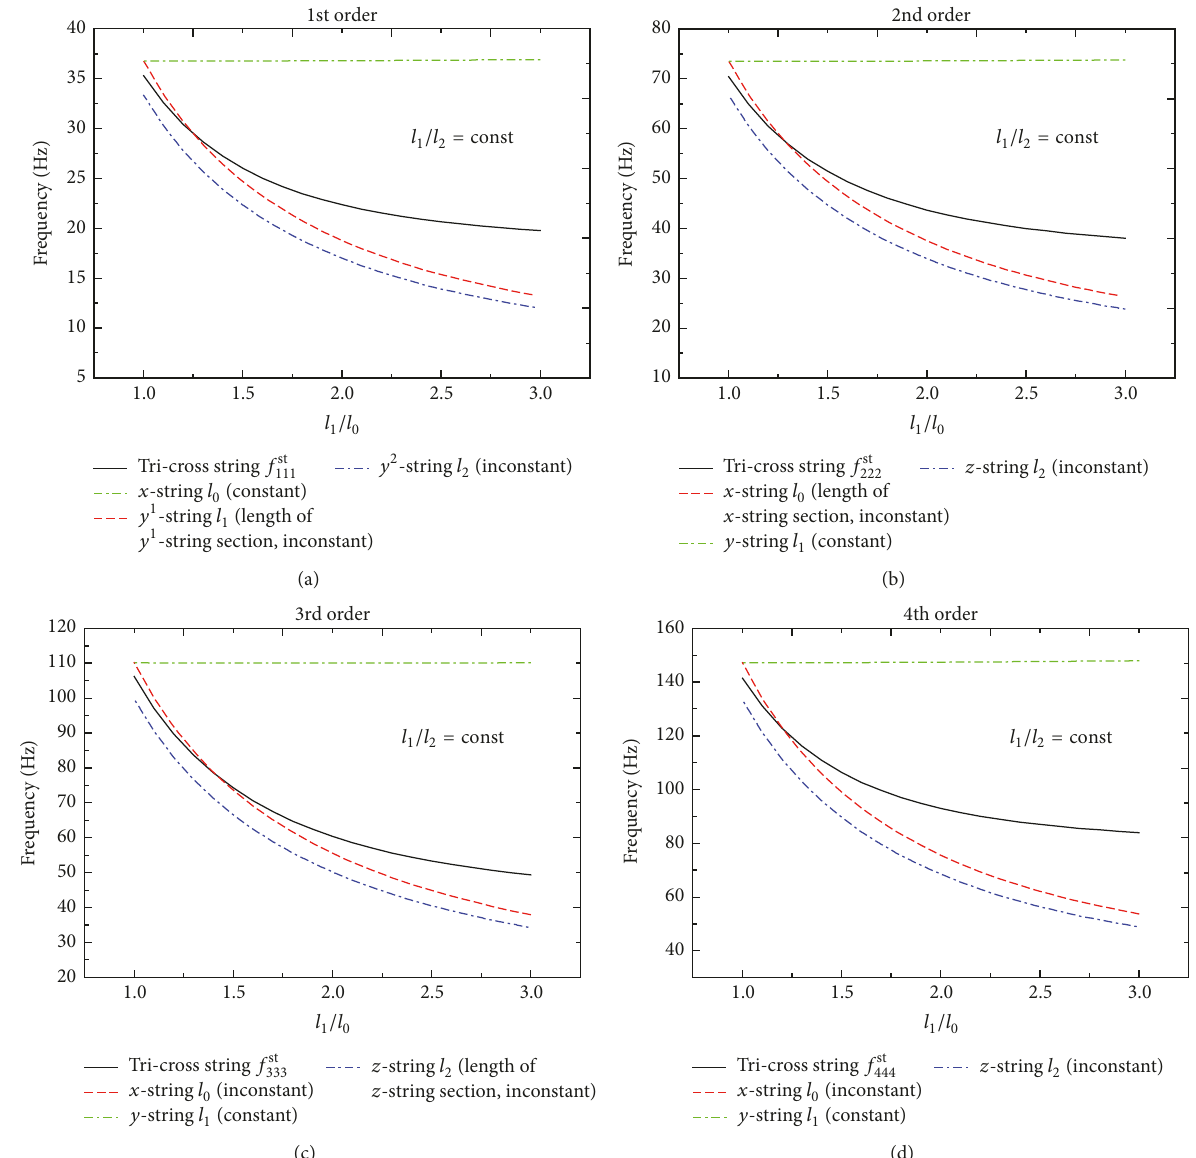
Figure 8: The influence of lengths of two constituent strings on the first four frequencies of the strings: (a) the first mode 𝑓 st 111 , (b) the second mode 𝑓 st 222 , (c) the third mode 𝑓 st 333 , and (d) the fourth mode 𝑓 st 444